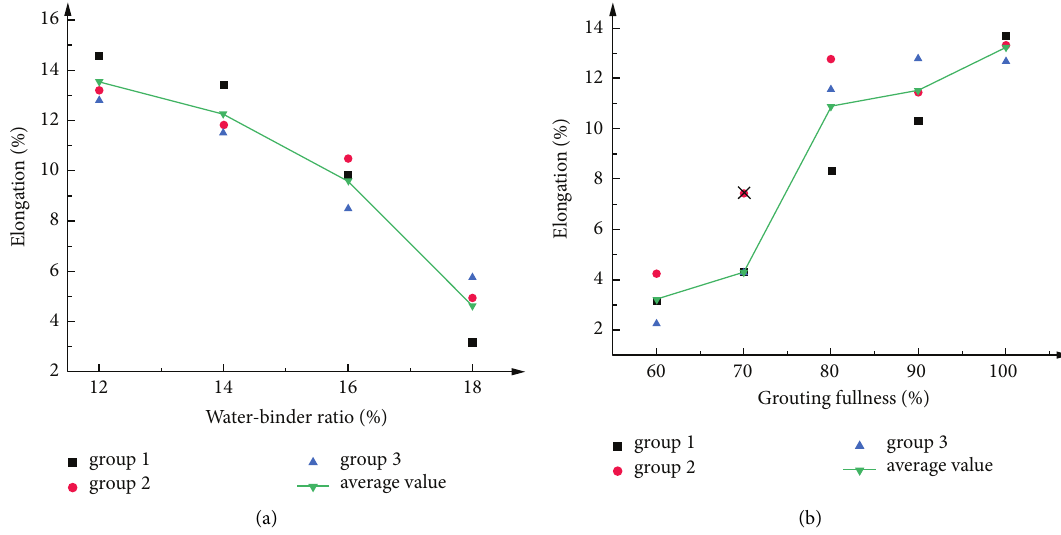
Figure 9: Comparison of elongation with different condition. (a) Different grout’s strength. (b) Different grouting